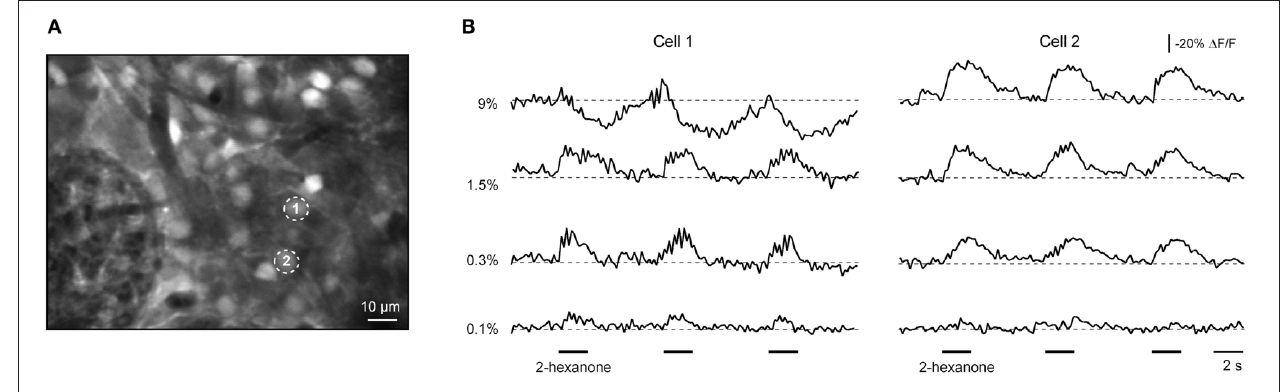
changed its response from ON to INHIBITED upon an increase in odorant concentration from 1.5% to 9% of saturated vapor. Cell 2 (cid:6) s response type was the same at all four odorant concentrations. The odorant was 2-hexanone.